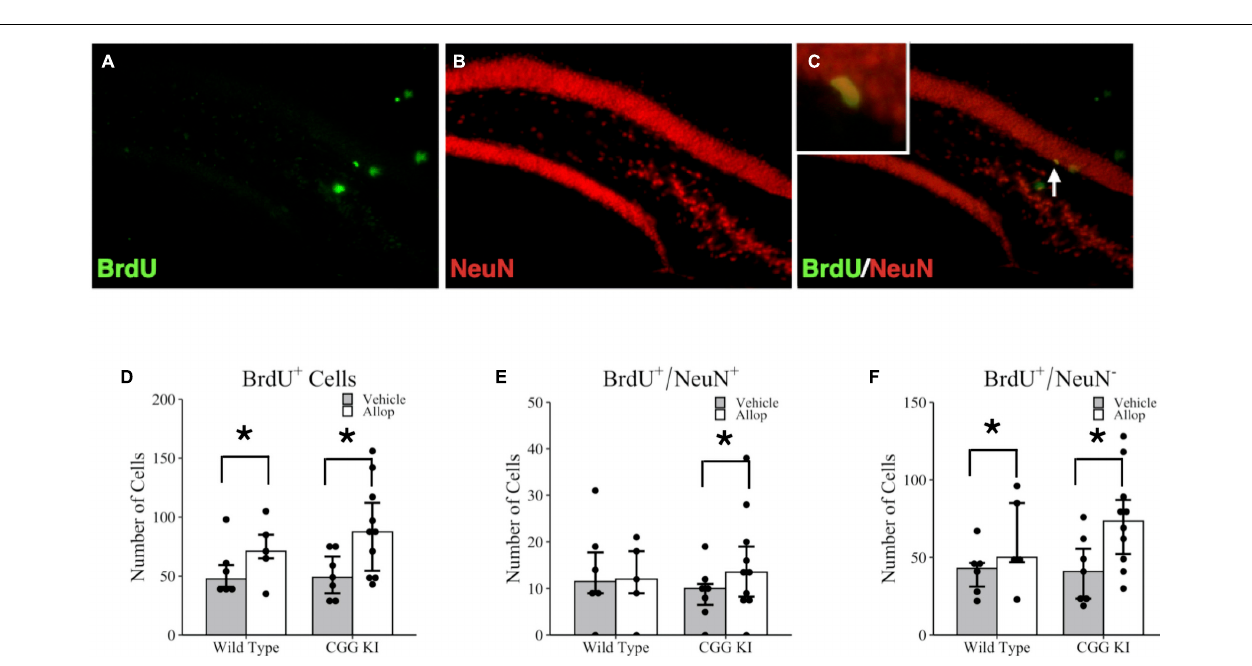
FIGURE 4 | Hippocampal cell proliferation and adult neurogenesis in the brains of CGG KI and wild type mice. Fluorescent photomicrographs of (A) BrdU + cells (green fluorescence) in the subgranular zone of the hippocampus. (B) Neurons were labeled with NeuN (red fluorescence), and (C) newly generated neurons are co-labled BrdU + /NeuN + and appear yellow (high magnification insert). Images shown at 20x magnification. (D) The total number of BrdU + cells in the subgranular zone of WT and CGG KI mice treated with Allop or vehicle for 10 weeks. (E) The total number of double labeled BrdU + /NeuN + cells reflecting adult neurogenesis in the dentate gyrus of the hippocampus. (F) The number of new cells not labeled with NeuN (BrdU + /NeuN − ) was calculated as the total number of number of BrdU + cells in (D) minus the total number of BrdU + /NeuN + in (E) . * p < 0.05 as determined by poisson regression (BrdU + and BrdU + /NeuN − ) or zero-inflated poisson regression (double-labeled BrdU + /NeuN + ) analysis followed by pairwise planned comparisons. Plots represent aggregated count data of individual mice; bars represent median + IQR. Wild type-vehicle ( n = 5), wild type-Allop ( n = 6), CGG KI-vehicle ( n = 7), CGG KI-Allop ( n = 10). BrdU, 5-bromo-2 (cid:48)